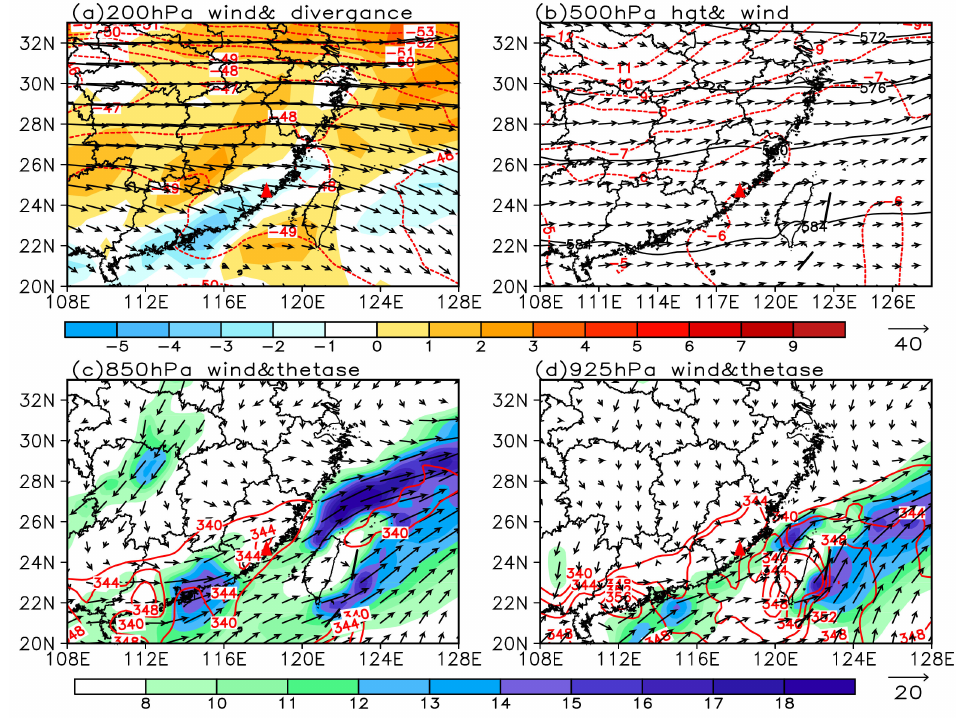
Figure 2. Weather charts at 14:00 LST on 30 April 2019: ( a ) 200 hPa wind (arrow), temperature (red broken lines; unit: ◦ C), and divergence (shading; unit: 10 − 5 s − 1 ); ( b ) 500 hPa geopotential height (isoline; unit: 10 geopotential meters), temperature (red broken lines; unit: ◦ C), and wind (arrow; unit: m s − 1 ); ( c ) 850 hPa; and ( d ) 925 hPa winds (arrow; unit: m s − 1 ) with a total wind speed (shading; unit: m s − 1 ) and θ se (contour; unit: K). The red triangle marks the area where the wind gust